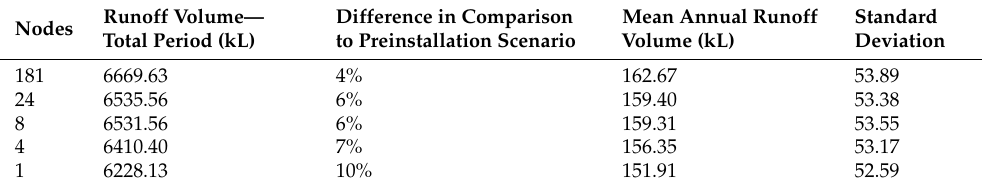
Table 6. The runoff volume produced with different levels of curbside leaky well aggregation.